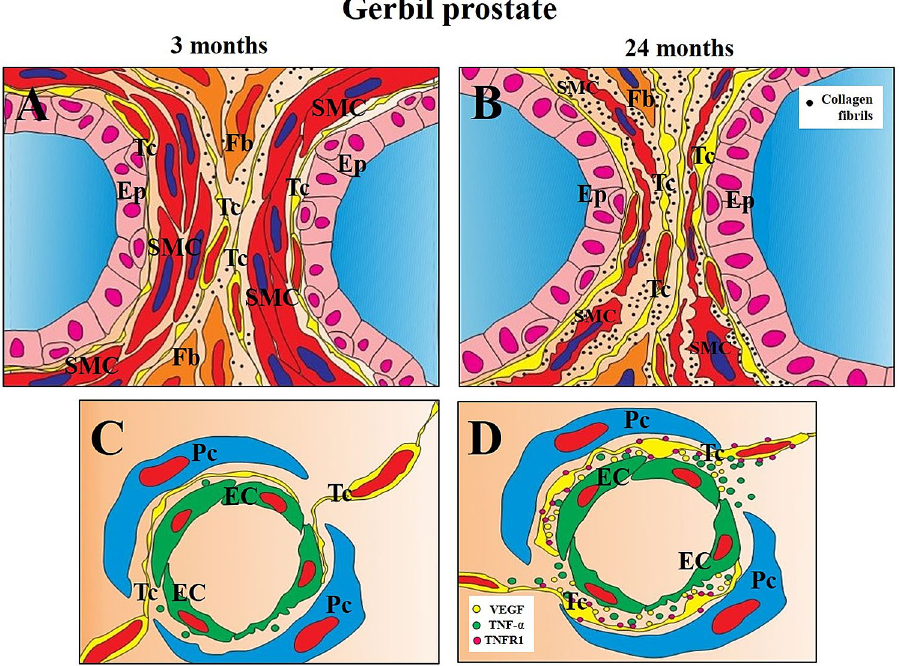
Figure 8. Schematic drawing depicting aspects of the aged prostate of male Mongolian gerbils and the telocytes ’relationships with other relevant tissue components. ( A ) The prostate of three-month-old animals (adults) has a compact layer of perialveolar smooth muscle; the telocytes occupy the periepithelial region, as well as the interstitium, surrounding the layer of perialveolar smooth muscle. ( B ) In the prostate of 24-month-old